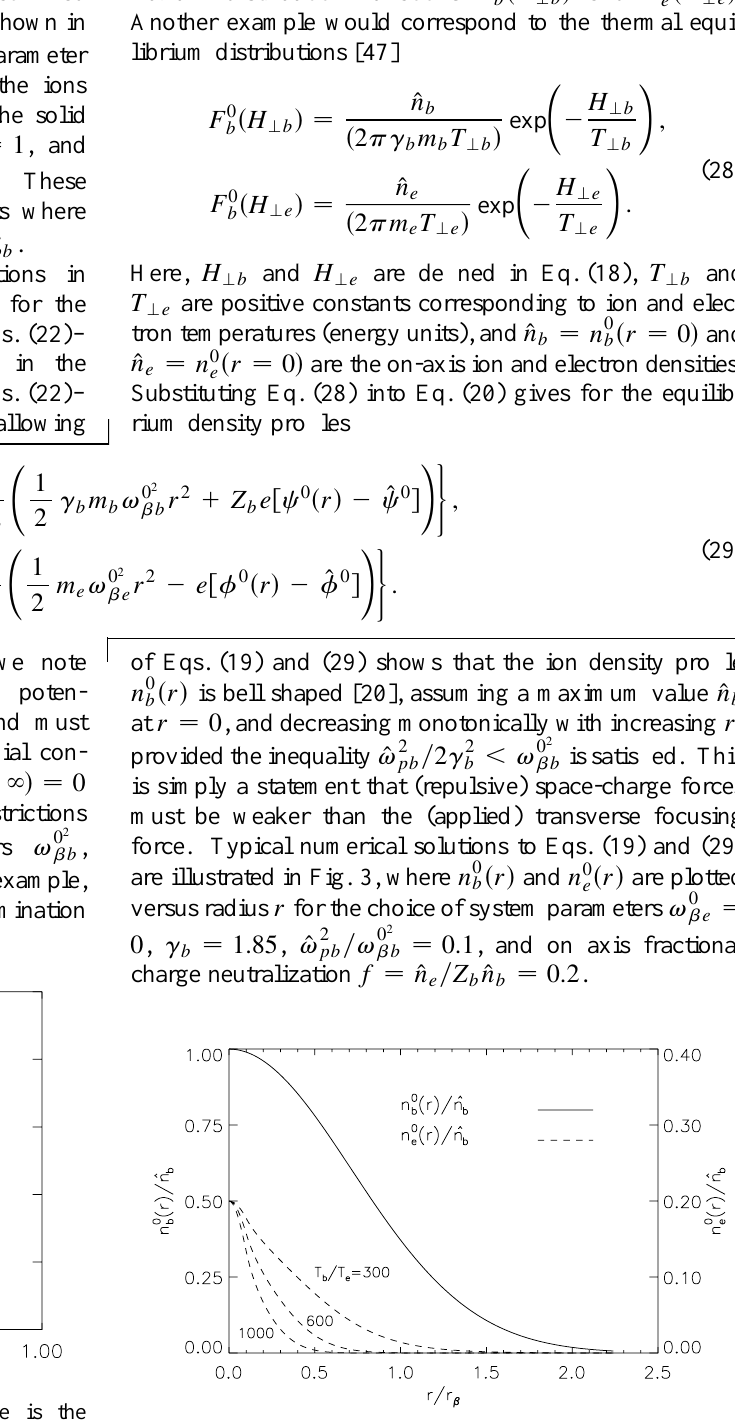
FIG. 3. Plots versus radius (cid:114) of (a) the ion density profile (cid:110) (cid:48) (cid:98) (cid:115) (cid:114) (cid:100)(cid:121) (cid:195) (cid:110) (cid:98) and (b) the electron density profile (cid:110) (cid:48) numerically from Eqs. (19) and (29) for the choice of